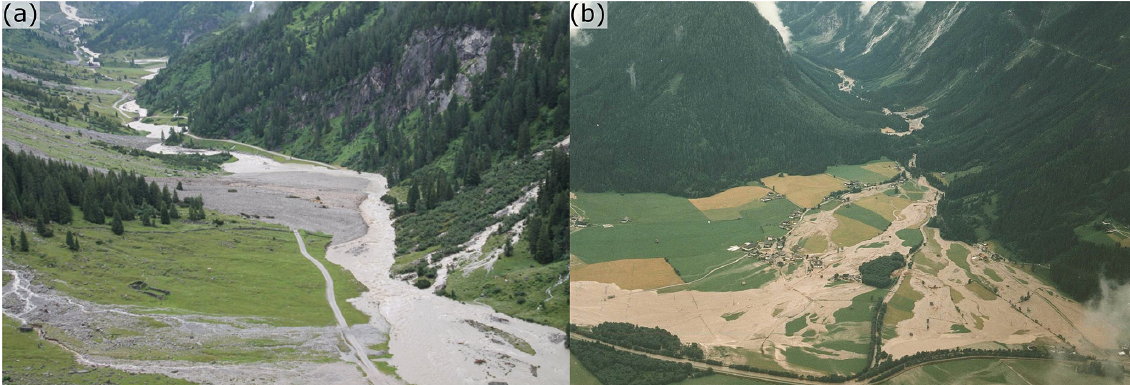
Figure 3. Obersulzbach valley, flood event September 2014. (a) Flooding situation in the Obersulzbach valley with the Sattelkar landslide cone deposit (image centre). (b) Flood area at the valley mouth in Sulzau and Schaffau. The river Salzach is at the bottom of the image. © Salzburger Nachrichten/Anton